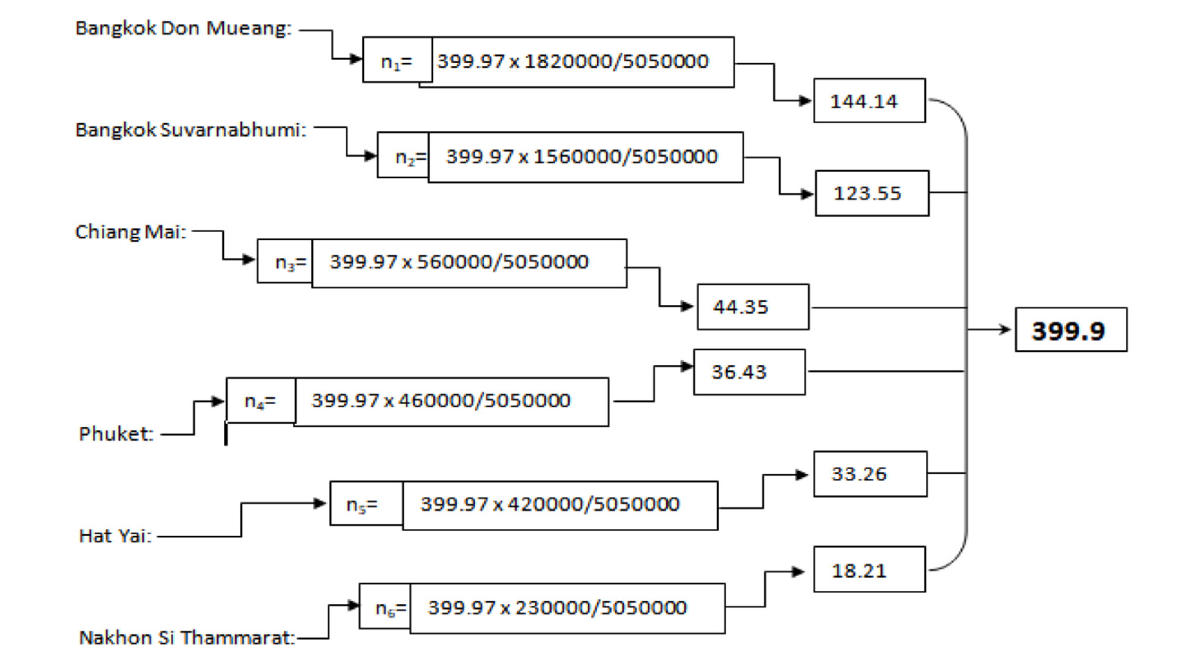
FIGURE3 Sample estimation.